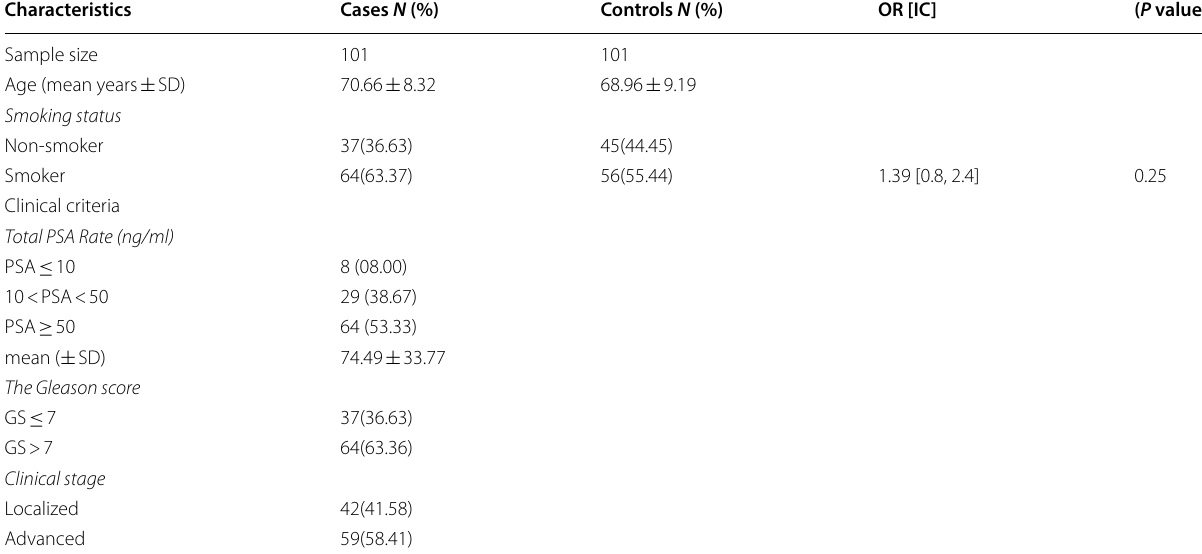
SD Standard deviation, PSA Prostate-specific antigen, GS Gleason score